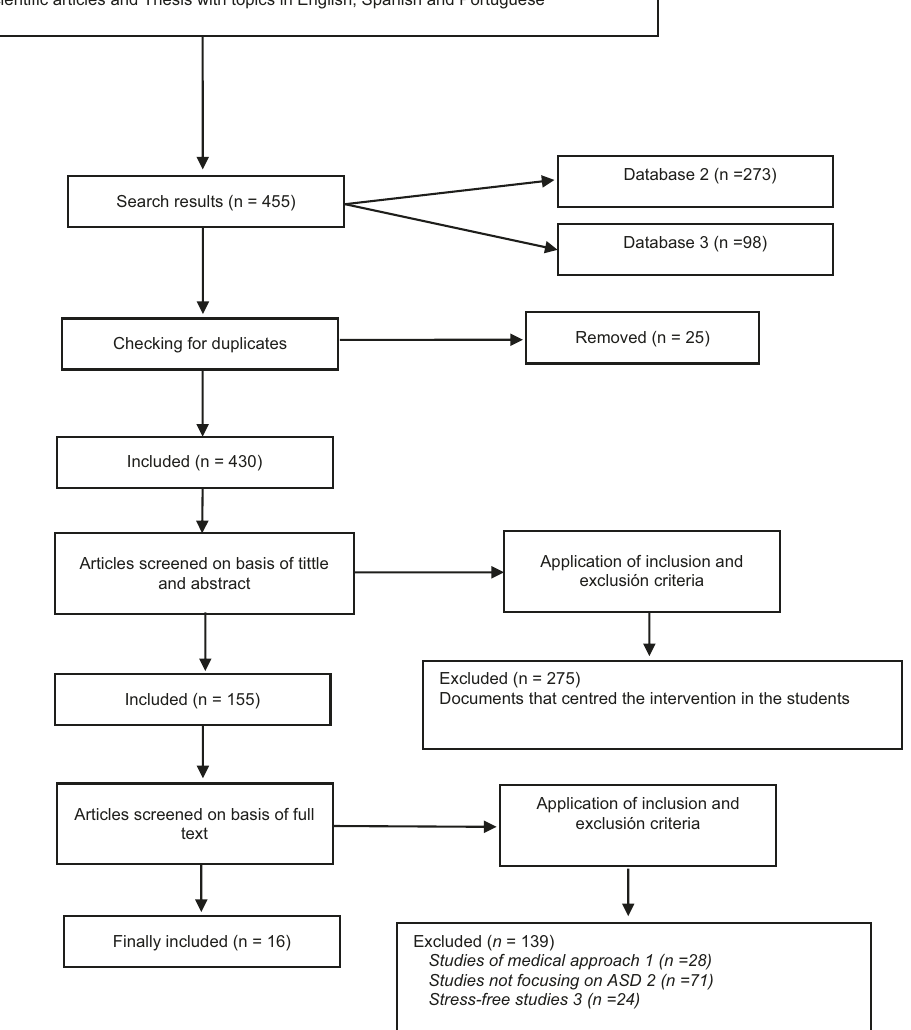
Fig. 1 Selection process: The process carried out for the search and selection of the different documents is shown. The selected search bases are detailed, as well as the total number of documents that appeared related to the subject in each one of them. After a review of the total number of documents, the repeated documents were eliminated, leaving a total of 430. This number was reduced by applying the inclusion and exclusion criteria, as well as different fi lters such as the reading of the title and the abstracts, fi nally obtaining 155 documents. Of the 155 documents, the inclusion and exclusion criteria fi lters were applied and 139 documents were eliminated. Finally, 16 were selected for the